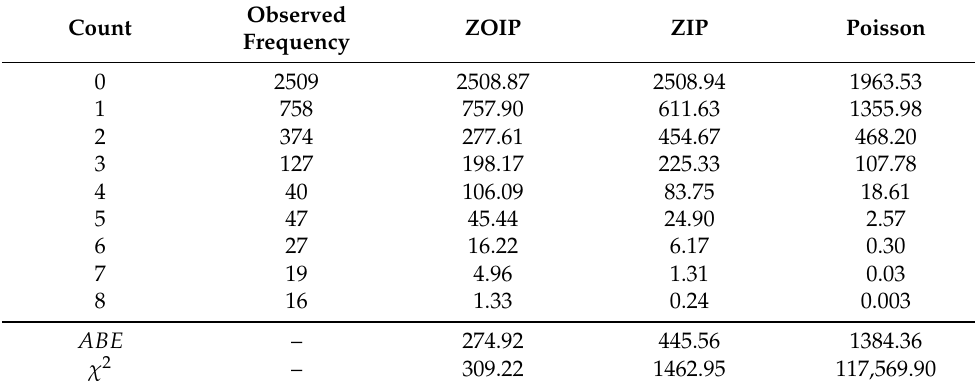
Table 11. Observed and expected frequencies of sunburn data.